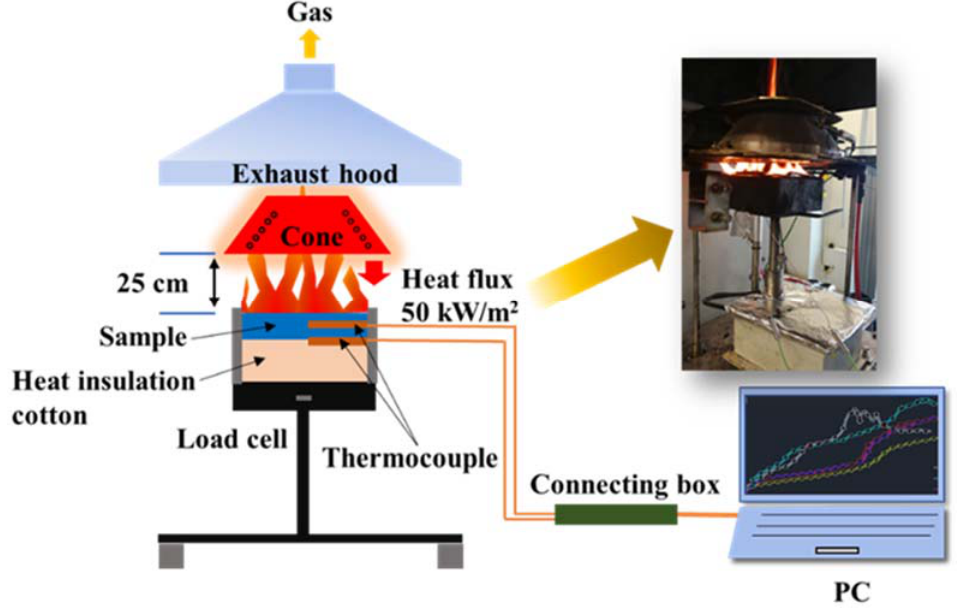
Figure 1. Schematic of experimental setup used for temperature measurements.